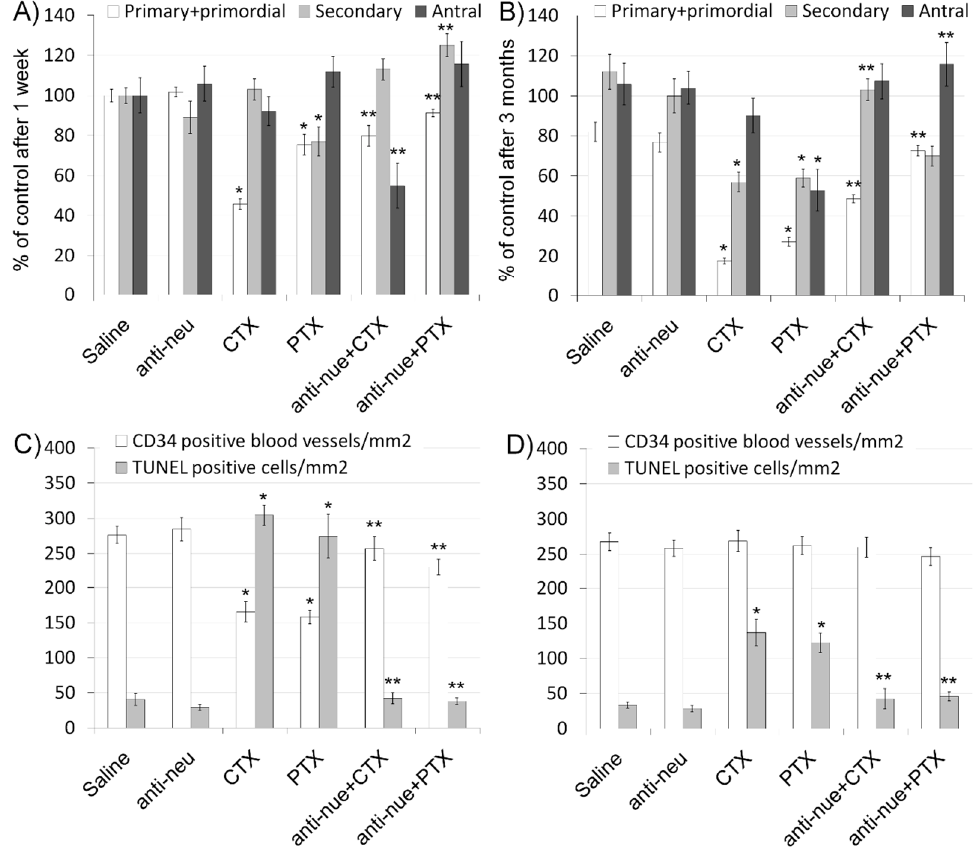
Figure 3. Ovarian follicles in mice after chemotherapy treatment with or without anti-HER2 / neu ( α -neu). Ovaries were processed as described in the legend of Figure 2 and the average number of primordial and primary (white bars), secondary (grey bars) and antral (black bars) follicles per transverse sections of ovary 1 week ( A ) or three months ( B ) after treatment was measured. Bars are mean ± SEM. (*)—significantly di ff erent from control value ( p < 0.05). (**)—significantly di ff erent from chemo only group (CTX or PTX without anti-neu; p < 0.05). The average number of CD34 positive blood vessels / mm 2 (white bars) and TUNEL positive cells / mm 2 (grey bars) ovary 1 week ( C ) or three months ( D ) after treatment was counted. Bars are mean ± SEM. (*)—significantly di ff erent from control value ( p < 0.05). (**)—significantly di ff erent from chemo only group (CTX or PTX without anti-neu; p < 0.05).